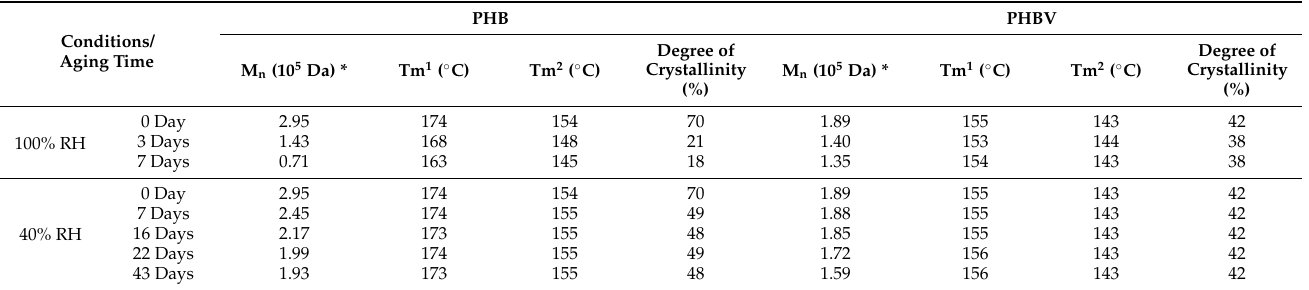
Table 3. Summary of the changes on M n , T m , and degree of crystallinity with aging time of PHB and